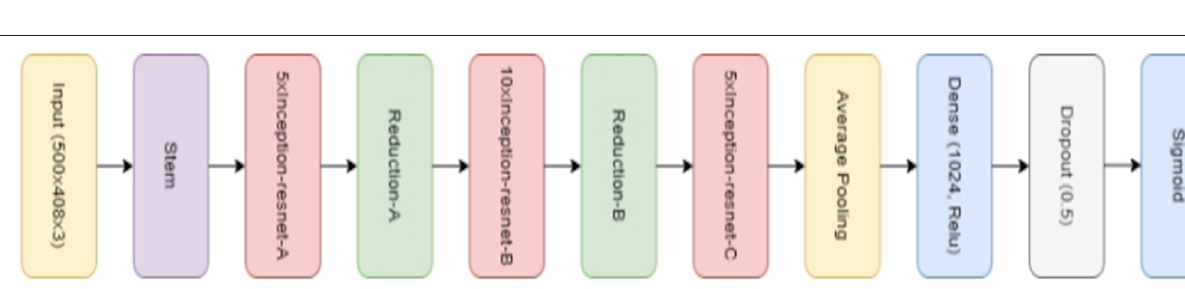
FIGURE 3 | The thumbnail view of the entire convolutional neural network (CNN) architecture.